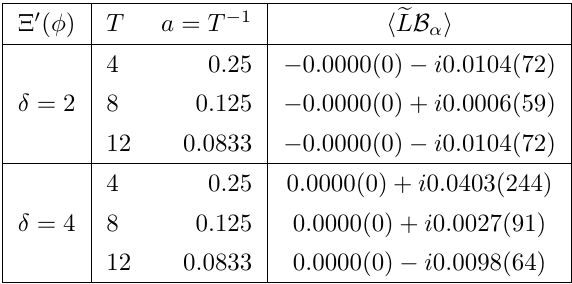
Table 6 . Expectation values of e L B α for the model with odd-degree ( k = 5 ) real-polynomial potential given in eq. (4.8). The parameters used are g phys = 3 , m phys = 1 , and µ phys = 4 . 0 .